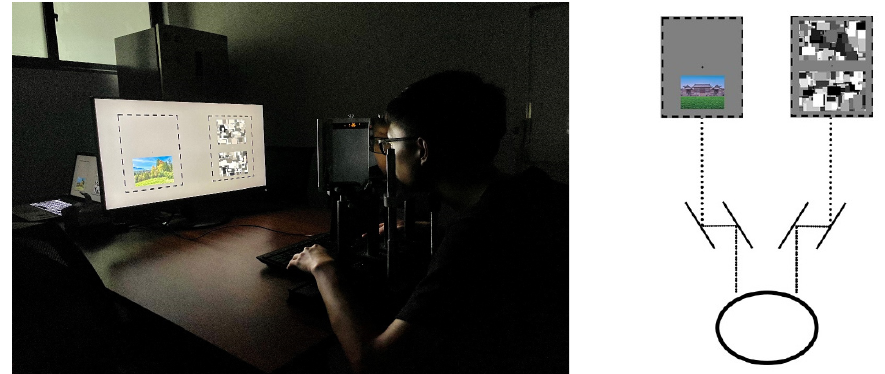
Figure 3. Illustration of the stereoscope setup.